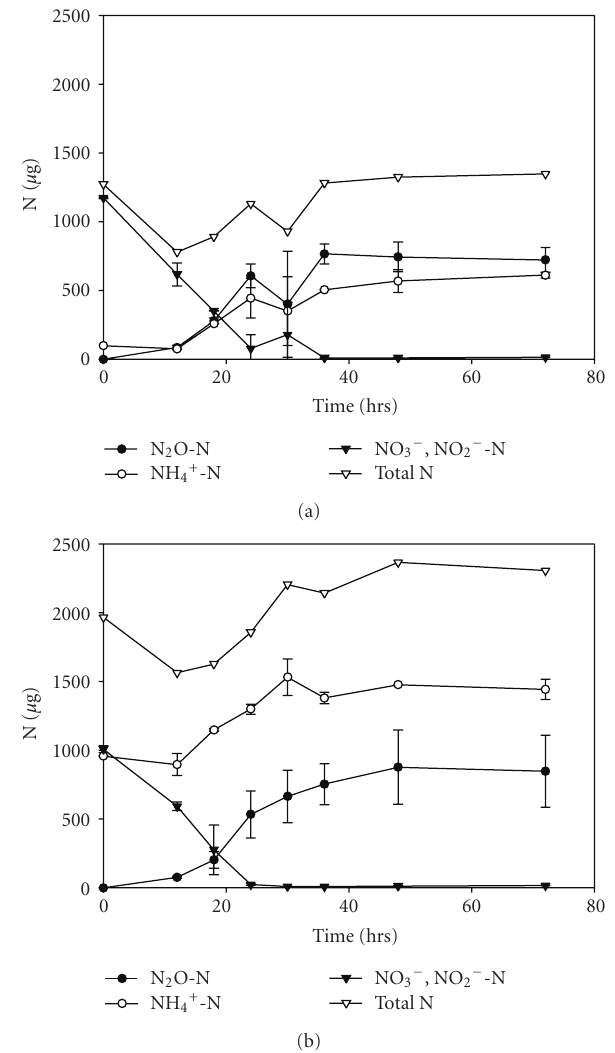
Figure 2: Concentrations of nitrogen species over time ( μ g N per vial) in Oyster Rake retention pond sediment microcosms amended with (a) 1400 μ g NO 3 -N per vial (NT) and (b) 1400 μ g NO 3 -N − + 1000 μ g NH 4 -N per vial (NA). Equivalent concentrations are 350 μ g N per gram dry weight for NO 3 − and 275 μ g N per gram dry weight NH 4+ .